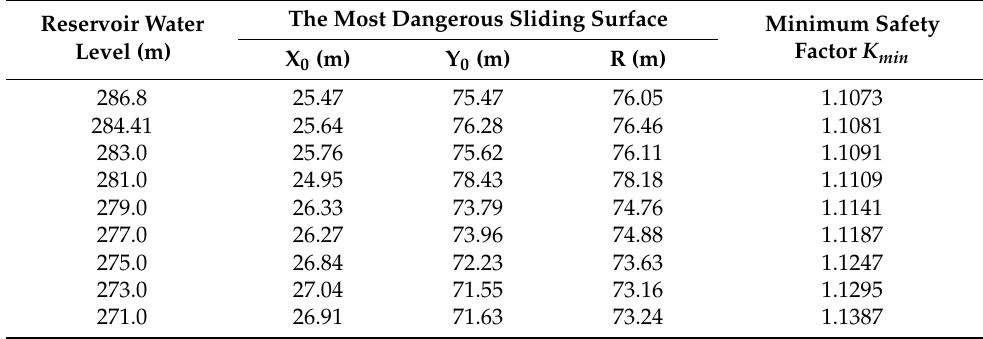
Table 5. The most dangerous sliding arc surfaces of the earth–rock dam.